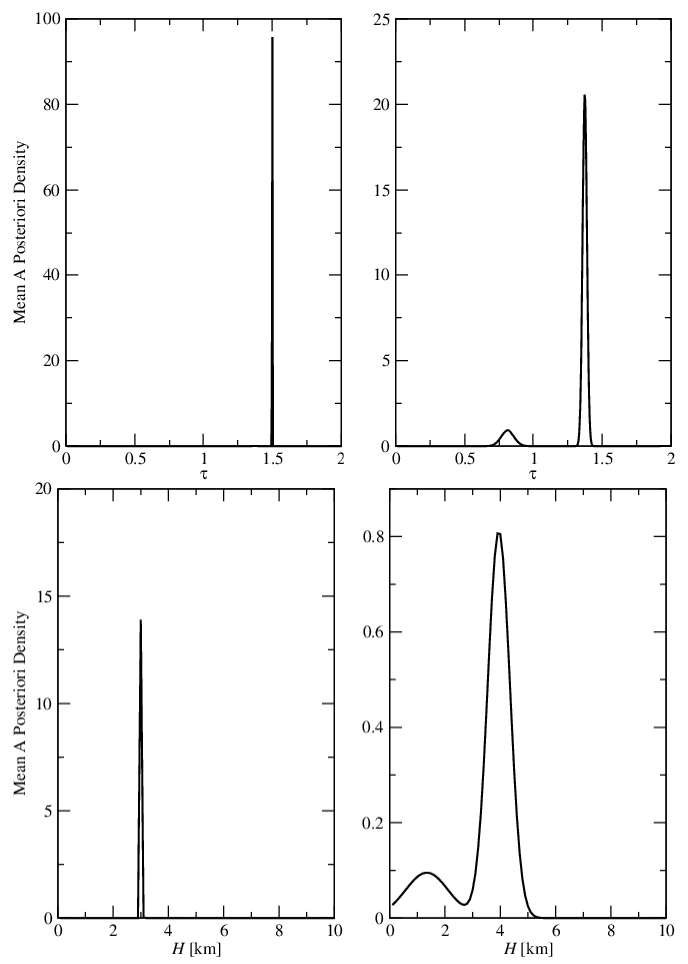
Figure 5. Upper panels: mean a posteriori density of τ computed by GCV for Test Examples 1 ( left ) and 2 (right). Lower panels: mean a posteriori density of H computed by GCV for Test Examples 1 ( left ) and 2 ( right ). The true values are τ t = 1.5 and H t = 3.0 km. Test Example 3